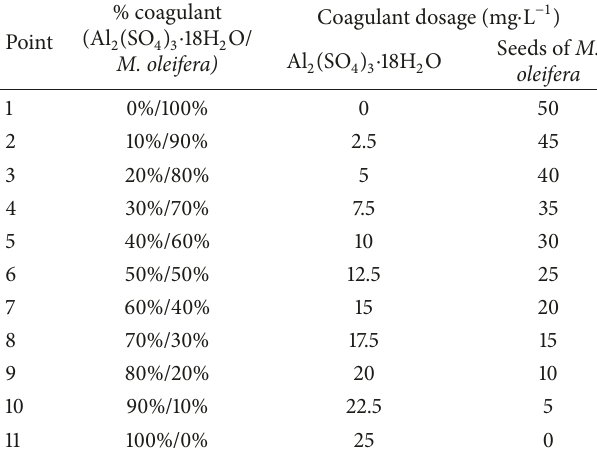
Figure 1: Removal efficiency of M. oleifera and aluminium sulphate for apparent